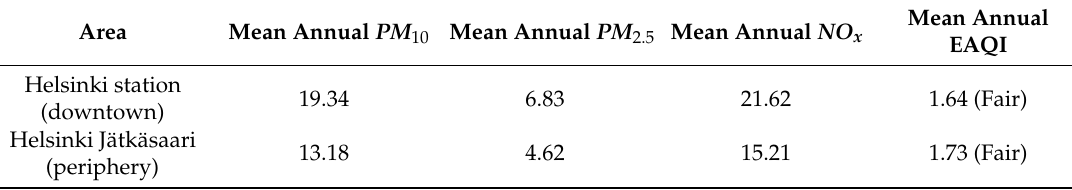
Table 1. Comparison among Helsinki station area and Jätkäsaari Island on Annual Means related to PM 10 , PM 2.5 , NO x , and Air Quality Index / European Air Quality Index (AQI / EAQI) for a single representative sensor in each